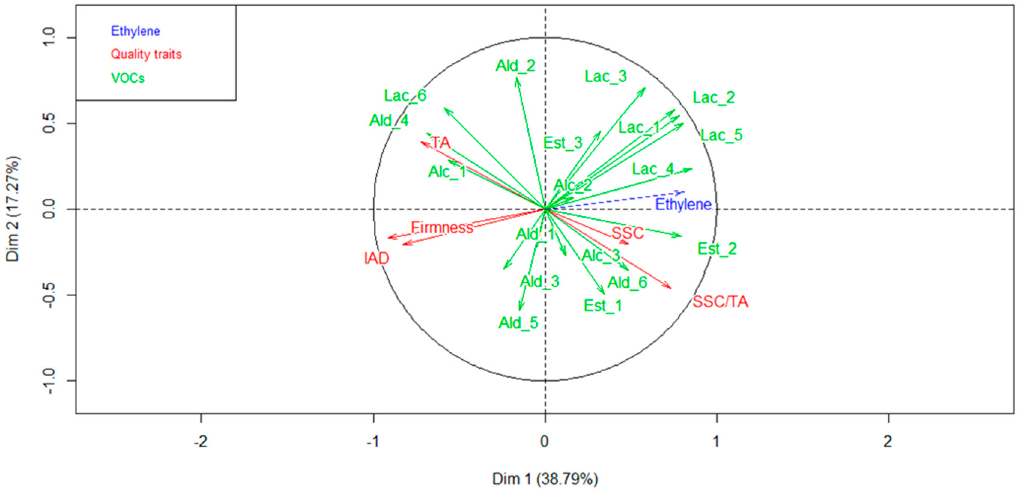
Figure 6. Multiple Factor Analysis. Variable plot projecting the different groups of variables (VOCs, quality traits, ethylene). VOCs ID is reported in Table 1.